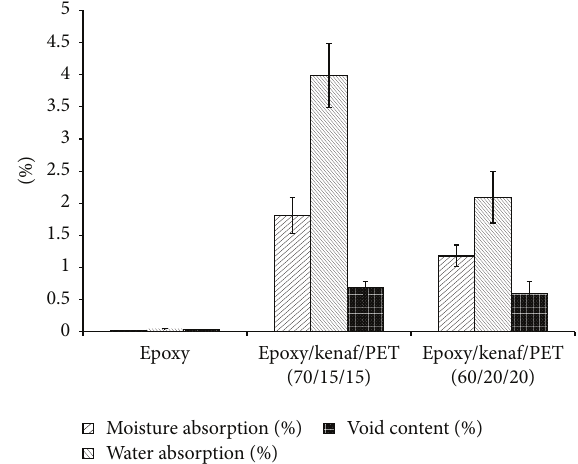
Figure 19: The results of moisture absorption test, water absorption, and void